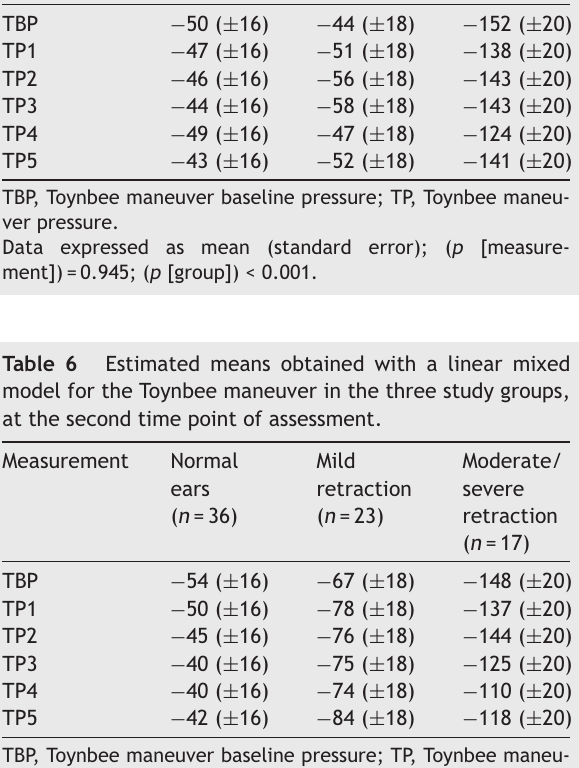
SBP, sniff test baseline pressure; SP, sniff test pressure. Data expressed as mean (standard error); ( p [measure- ment]) = 0.477; ( p [group]) < 0.001.